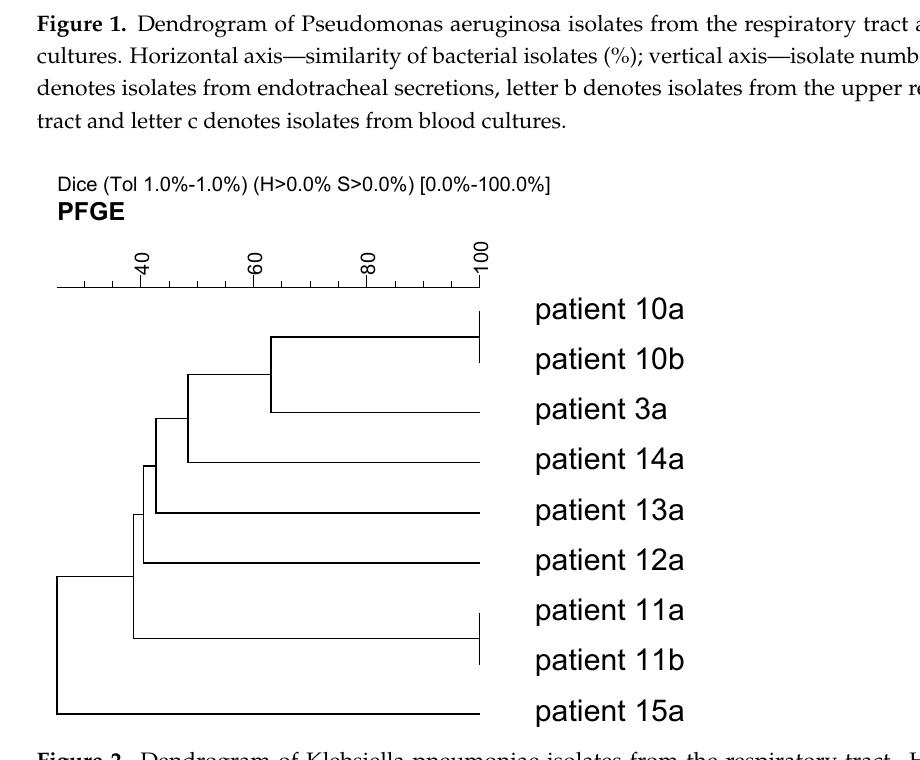
Figure 2. Dendrogram of Klebsiella pneumoniae isolates from the respiratory tract. Horizontal axis—similarity of bacterial isolates (%); vertical axis—isolate number; letter a denotes isolates from endotracheal secretion and letter b denotes isolates from the upper respiratory tract.